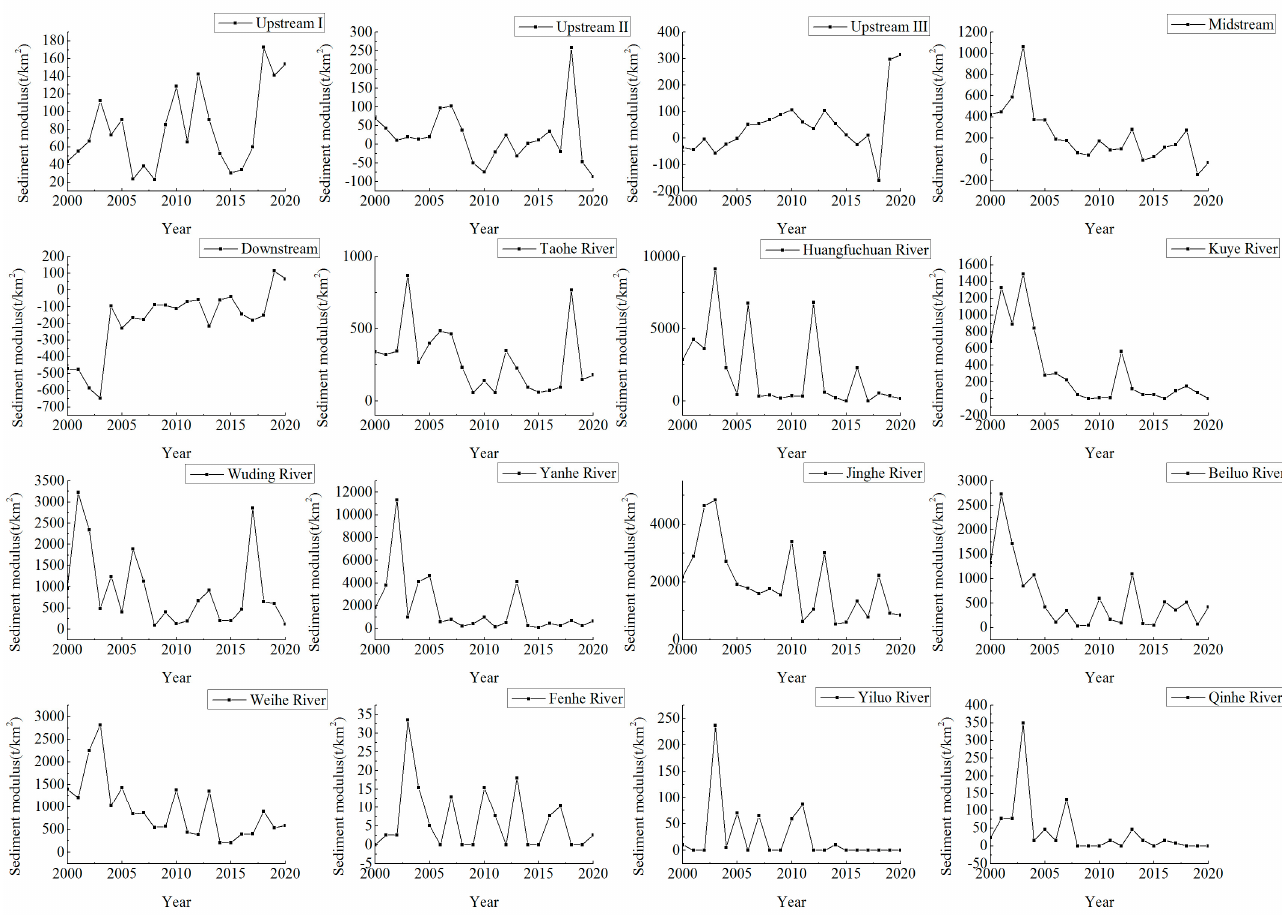
Figure 9. Changes in the sediment modulus in the main stream and tributaries of the Yellow River basin; this figure includes the change in sediment modulus in each division of the main stream and tributaries.